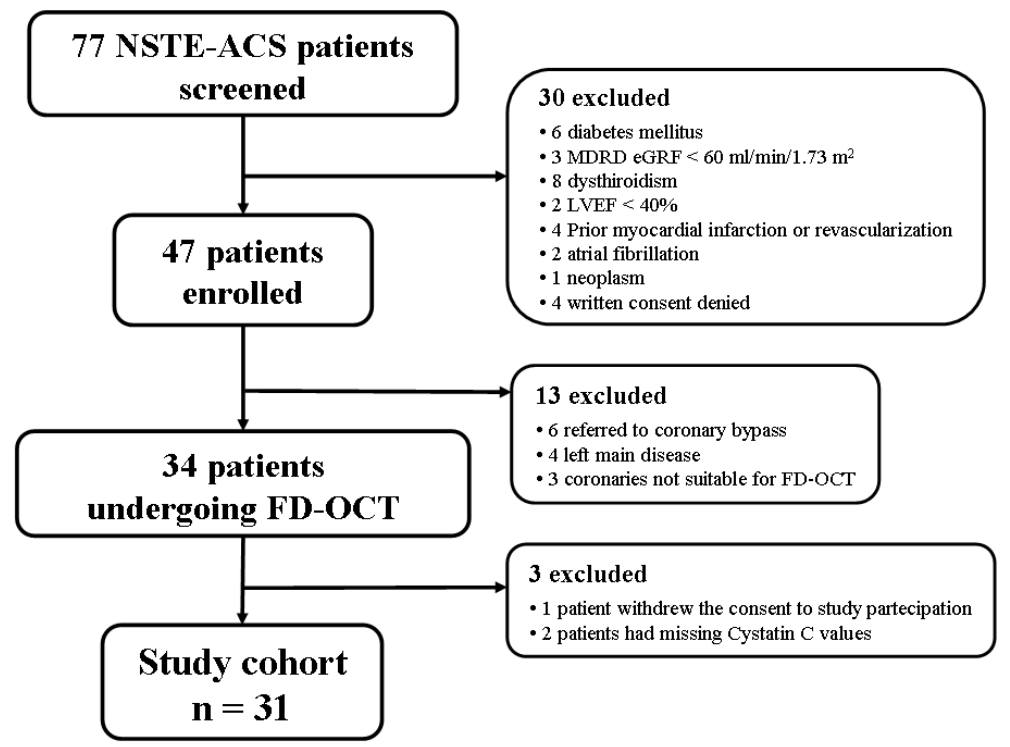
Figure 1. Study flow chart. Abbreviations: LVEF = left ventricle ejection fraction, MDRD eGRF = Modified Diet in Renal Disease estimated Glomerular Filtration Rate, 18 F-FDG-PET/CT = 18 F-Fluorodeoxyglucose-Positron Emission Tomography/Computed Tomography, FD-OCT = Frequency Domain-Optical Coherence Tomography, NSTE-ACS = Non-ST-segment Elevation-Acute Coronary Syndrome. Table 2. Atherosclerotic features as assessed using a multimodality imaging approach according to cystatin C values.